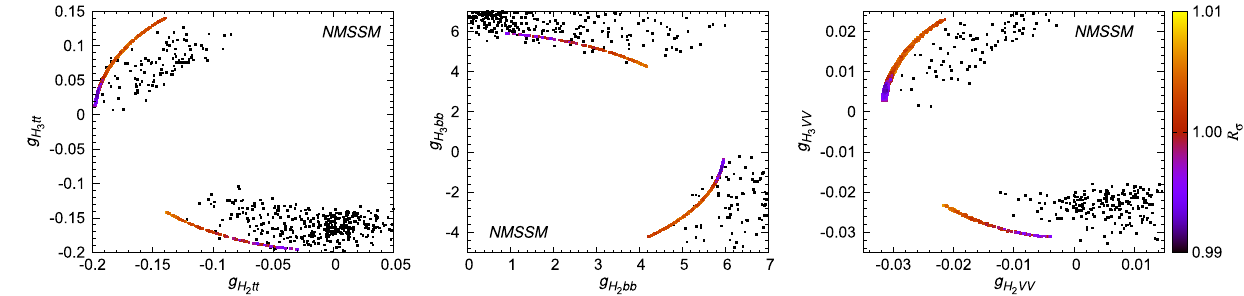
Fig. 4 H 2 and H 3 couplings to t ¯ t (left), b ¯ b (centre) and V V (right) pairs in the NMSSM, with the colour map showing the ratio of the cross sections corresponding to cases b and c for the points with (cid:11) m <